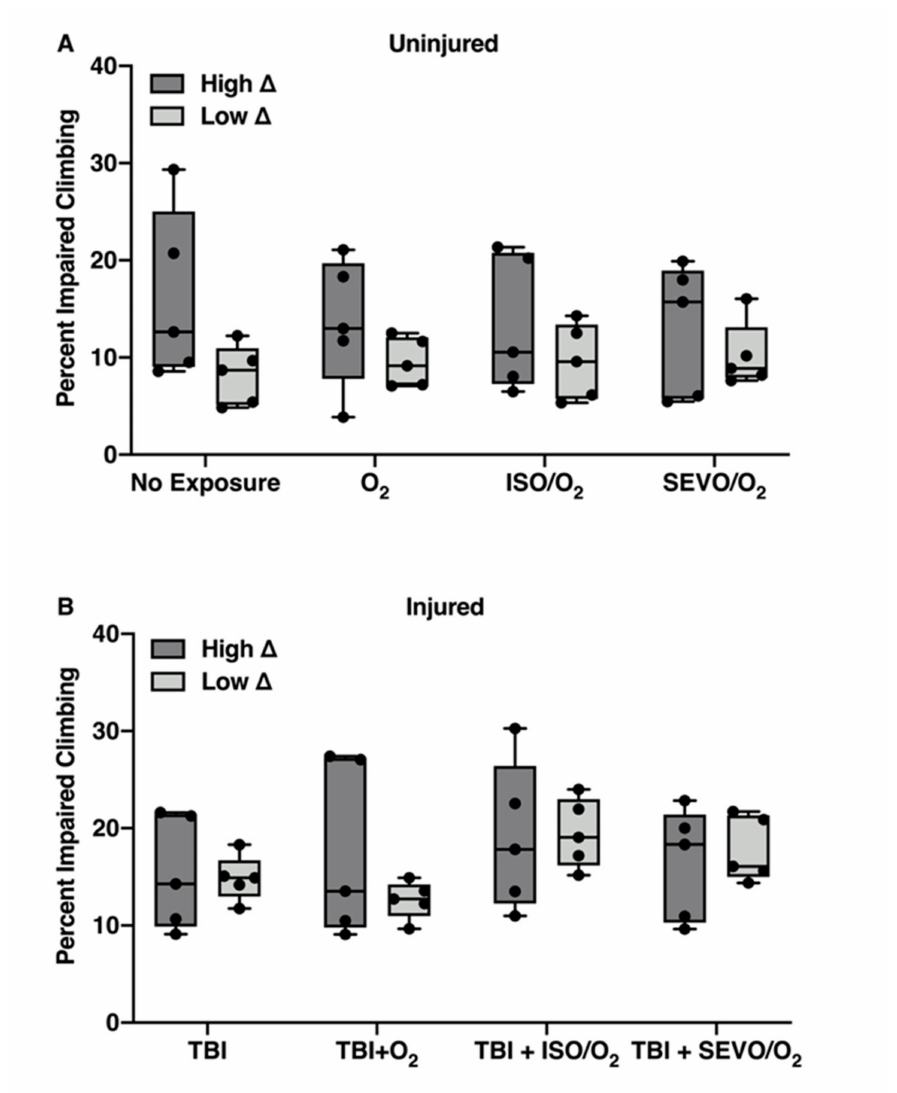
Figure 6. Classification into high ∆ and low ∆ groups predicts e ff ects on locomotion. ( A ) Box plots of percent impaired climbing for uninjured flies from the five RAL lines in the high ∆ and low ∆ groups under the indicated treatment conditions. Horizontal bars indicate the median, and whiskers extend to the minimum and maximum data points. ( B ) Flies were analyzed and treated as in panel A, but they were injured using the standard TBI protocol prior to exposure. Note the higher degree of dispersion in the high ∆ group vs. the low ∆ group (SD = 8.8 vs. 3.1) without injury, which was also present after TBI and exposure to O2 and ISO / O2 in the high ∆ group (SD = 9.0 and 7.7, respectively, vs. 1.9 and 3.6, respectively, for low ∆